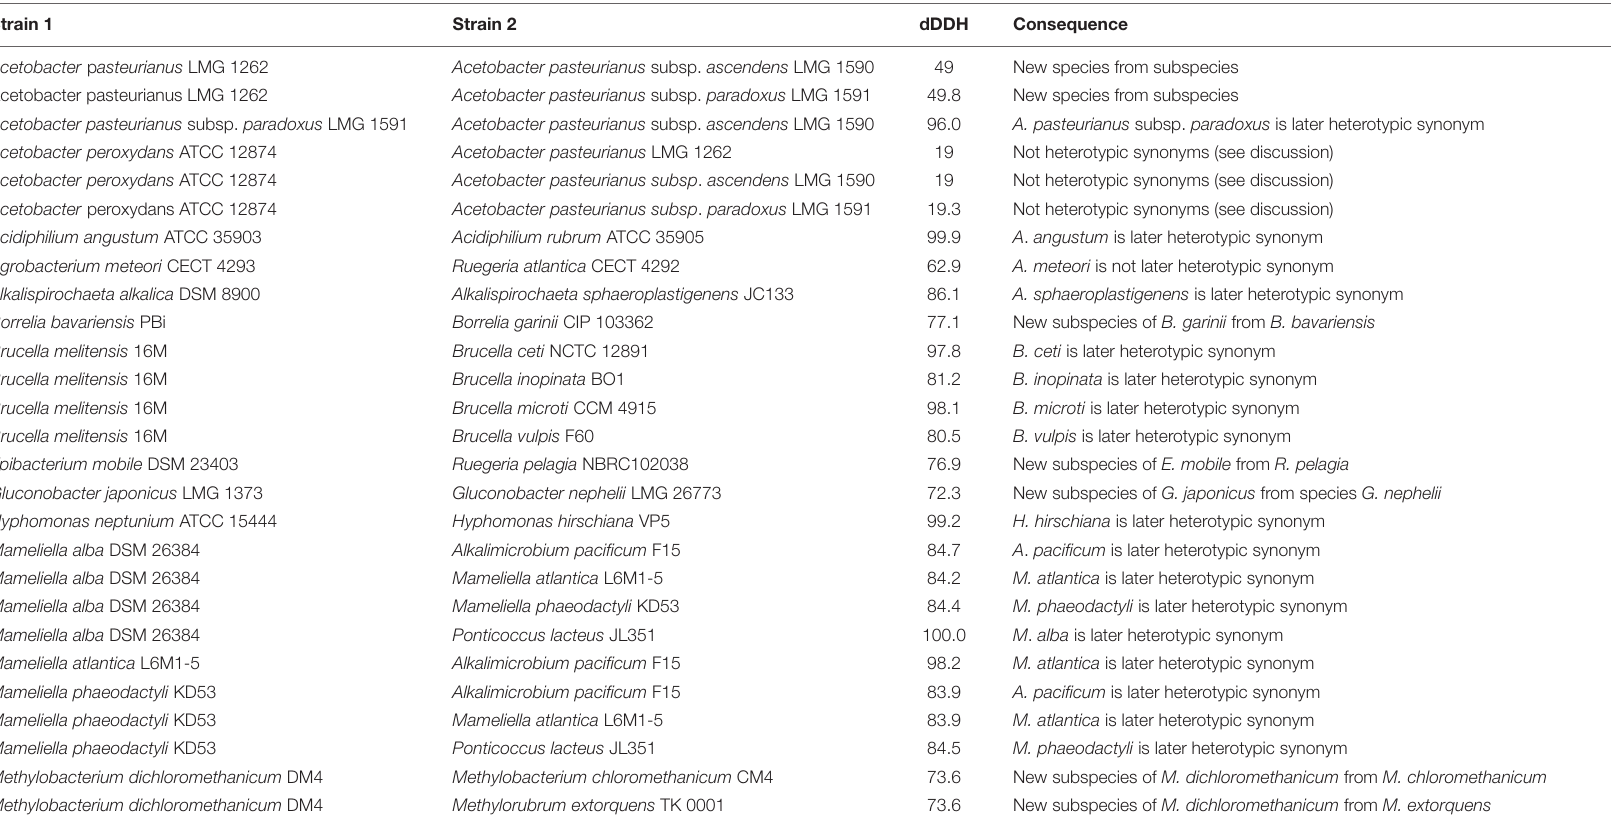
TABLE 1 | Outcome of applying GGDC to calculate intergenomic dDDH values. Strain